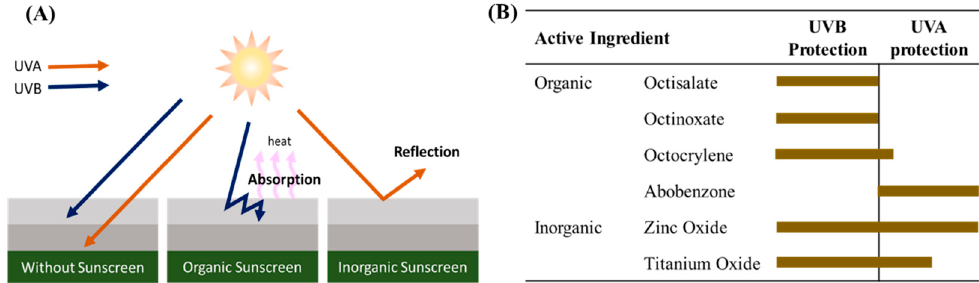
Figure 1. ( A ) Schematic illustration of the way in which organic and inorganic sunscreens protect against ultraviolet ( UV ) radiation and ( B ) the active ingredients for protection against UV - A ( 320–400 nm ) and UV - B ( 280–320 nm ) rays .